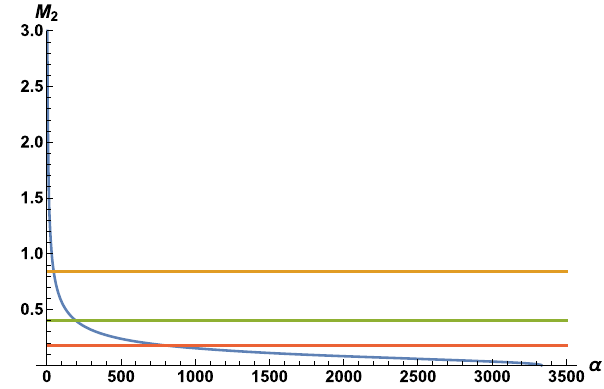
Fig. 3 Plots of mass M 2 for a massive spin-2 as a function of α with l = 10 and κ = 1 in the α = − 3 β Einstein–Ricci cubic grav- ity. Three horizontal lines correspond to M c 0 . 84 , 0 . 40 , 0 . 18 where the critical gravity appears. The mass M 2 is zero at α = α ∗ =